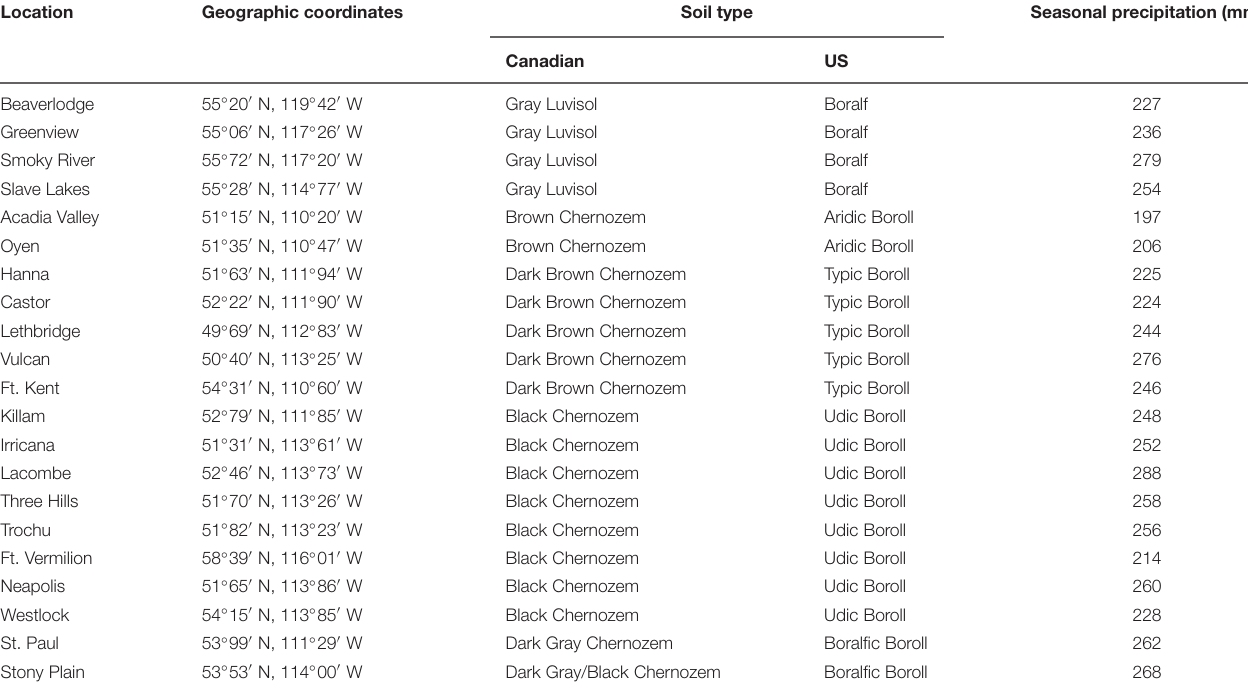
TABLE 1 | Soil types and seasonal precipitation † in the study locations in Alberta.